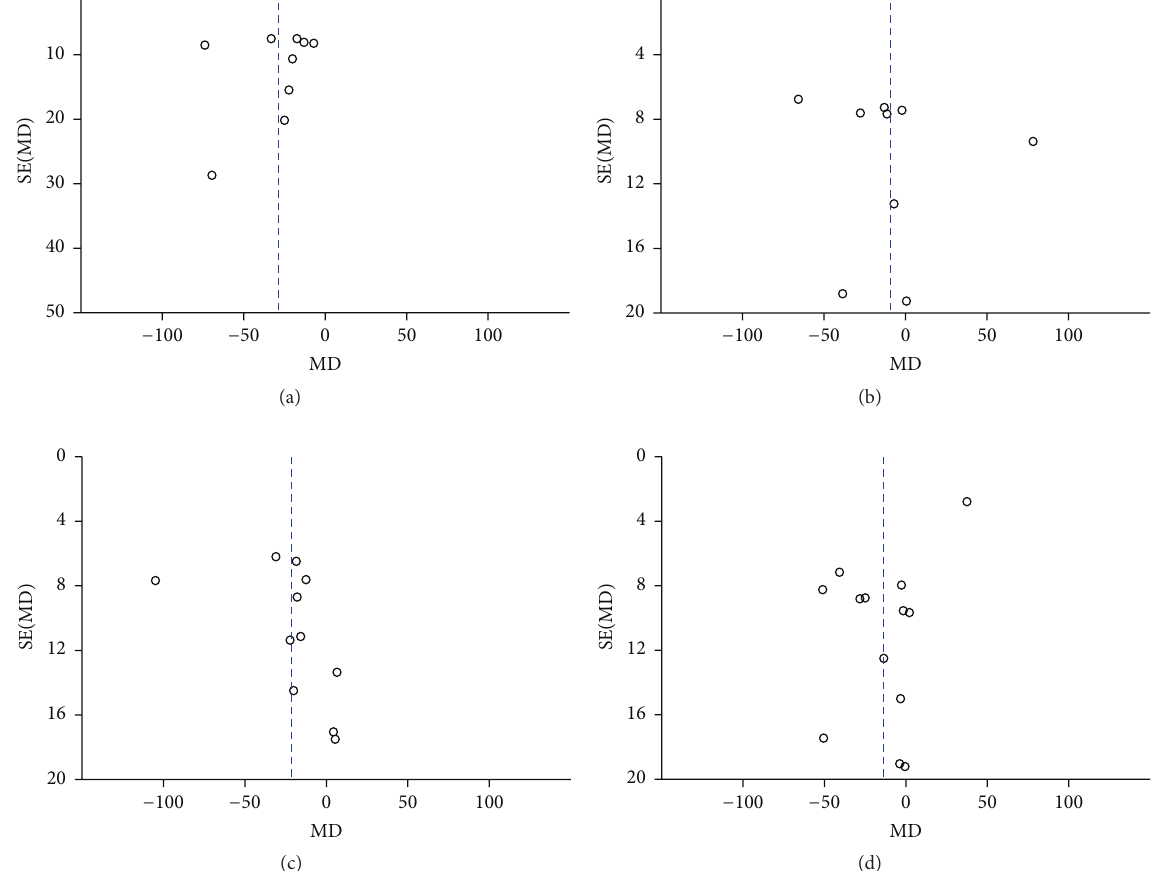
the measurements were conducted at different locations.